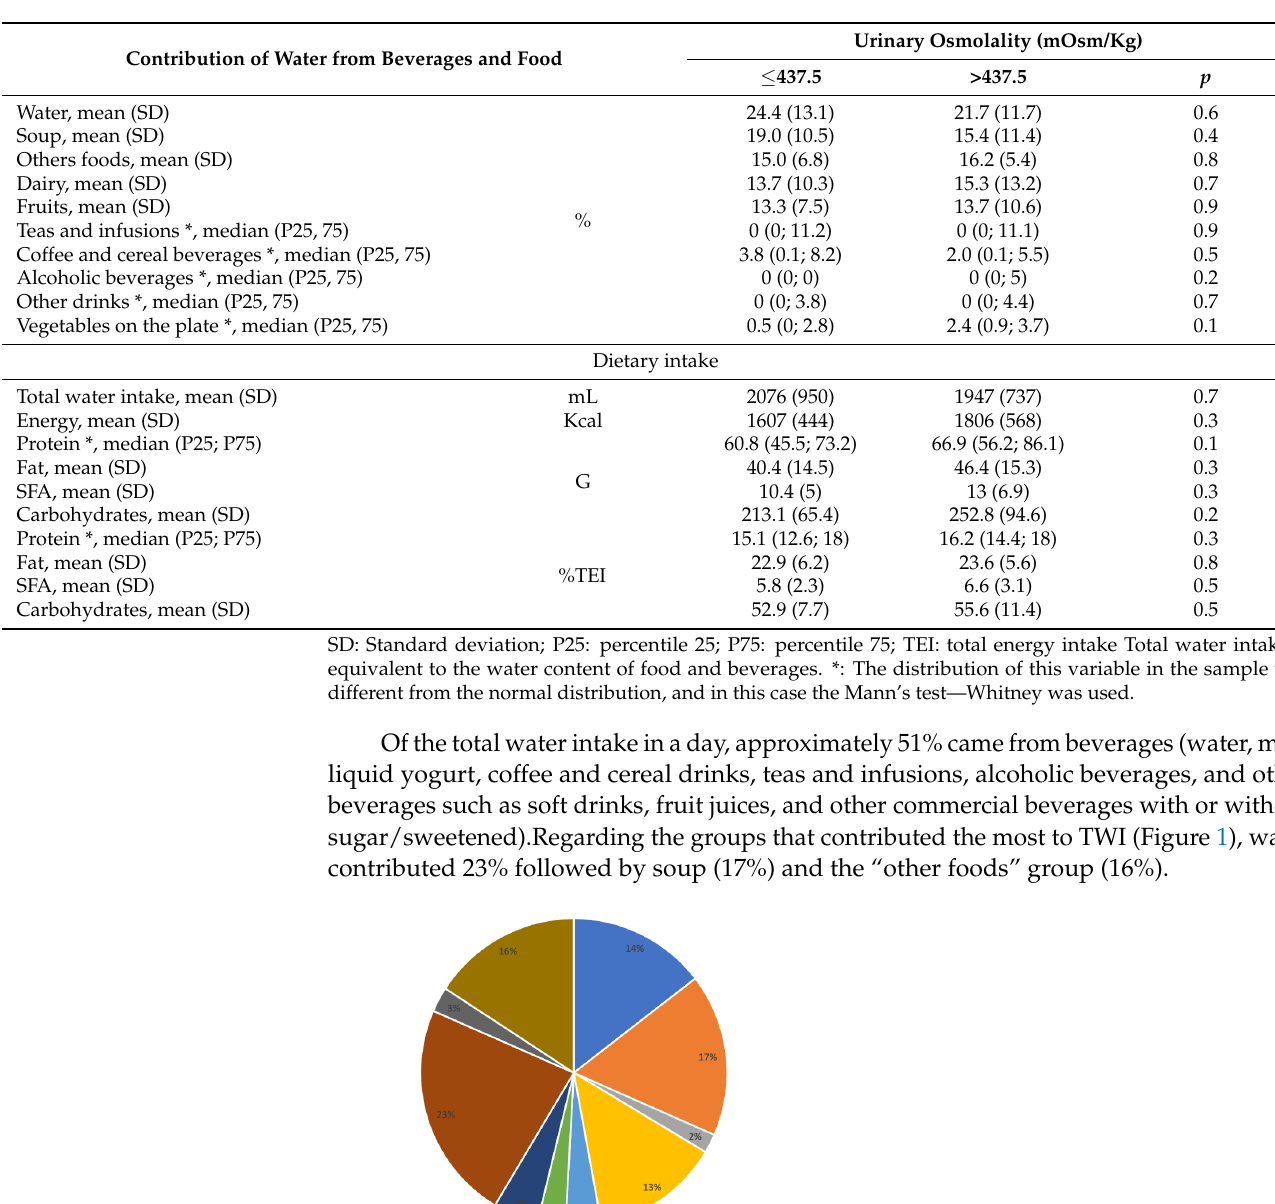
Table 3. Contribution of water from beverages and food and dietary intake according to the median of urinary osmolality.